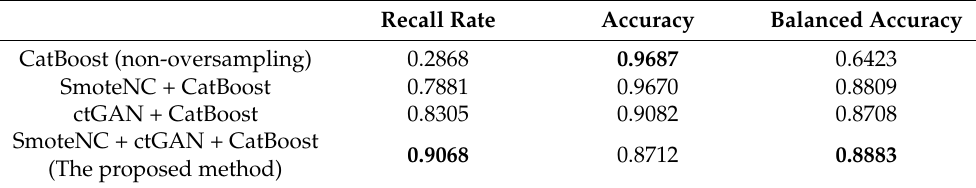
Table 17. Results obtained using different methods in multicategory fault